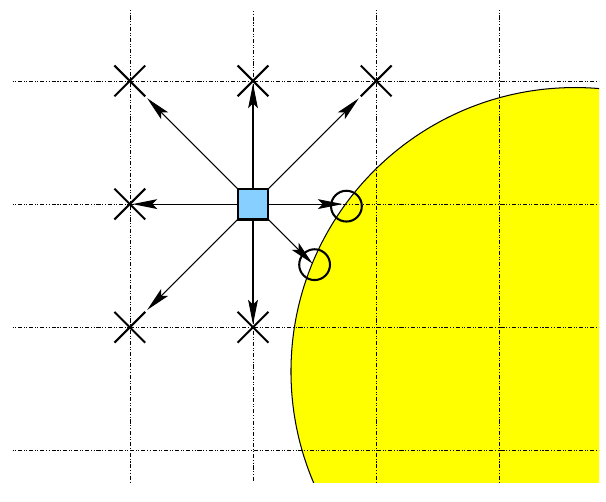
Fig. 4. 2-D analog of the averaging procedure. At each grid point r I ∈ I (shaded central box), a weighted average is computed from time-advanced values taken at neighbors outside S (crosses), and boundary values taken in the direction of neighbors inside S (cir- cles). The factors L Iα entering into Eq. (19) are equivalent to the length of arrows in the